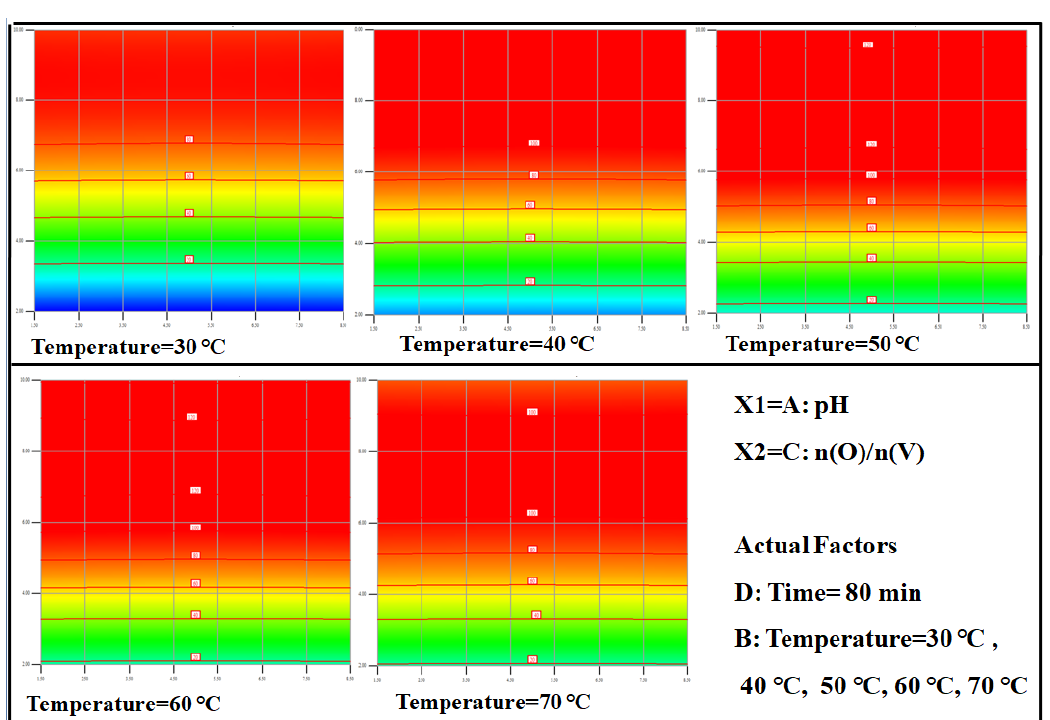
Figure 7. Response surface plots for factors (A to C).